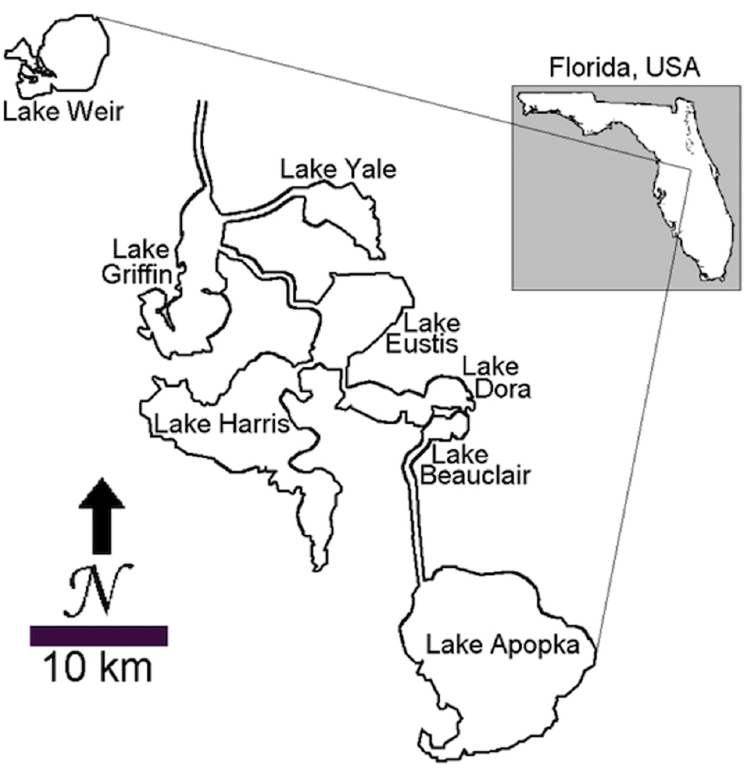
Fig 1. Location of Lake Harris within the Harris Chain of lakes; 28˚46 0 4 @ N 81˚48 0 57 @ W. Reproduced from [23] with permission from Springer, license number 4111351386595.